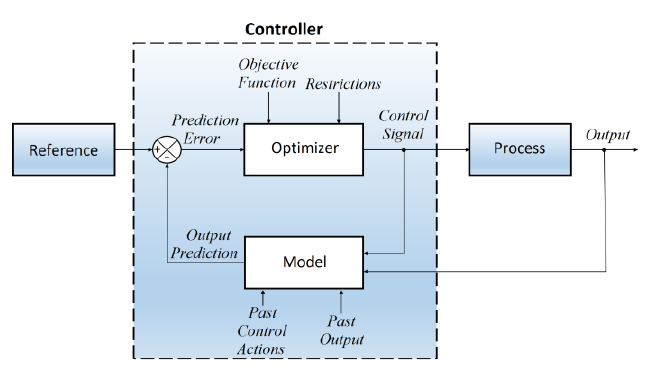
Figure 2. MPC controller block